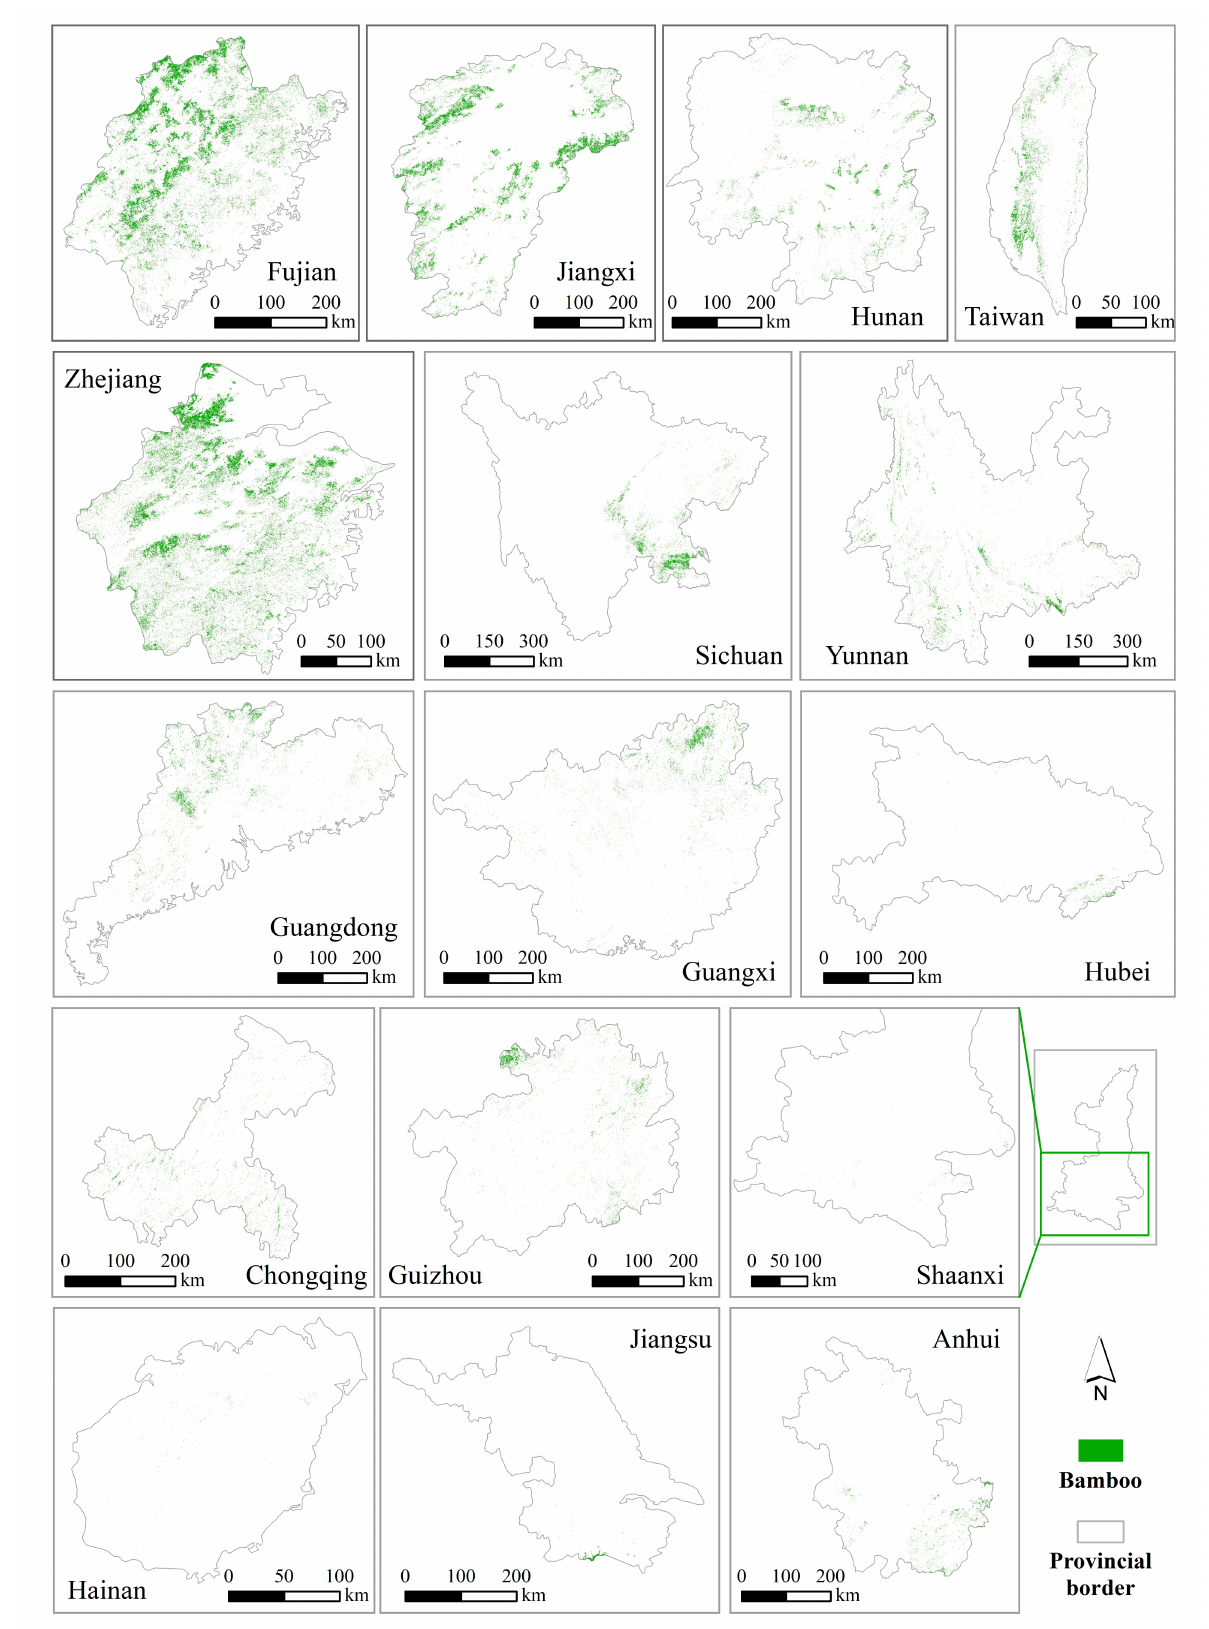
Figure 5. The spatial distribution of bamboo in the 16 provinces